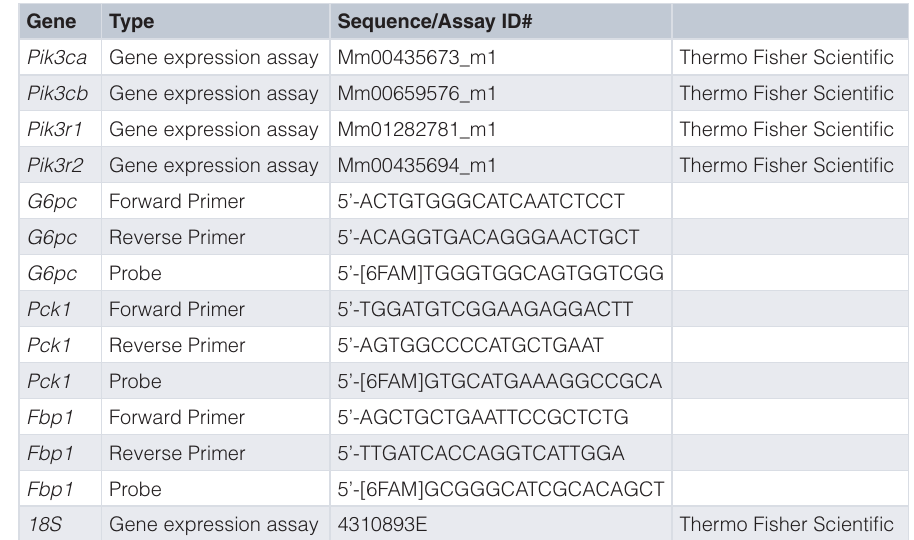
Table 1. Primer used for gene expression